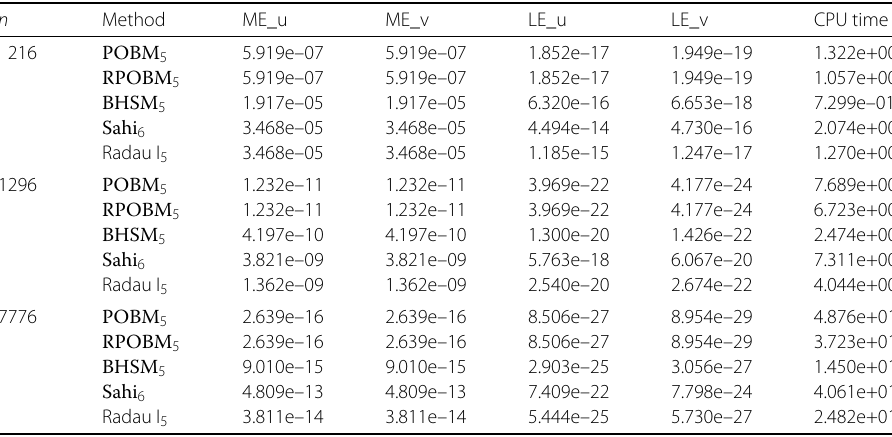
Table 3 Comparison of the methods under consideration on the basis of absolute errors and CPU time for the stiff Problem 3 with different number of steps ( n )